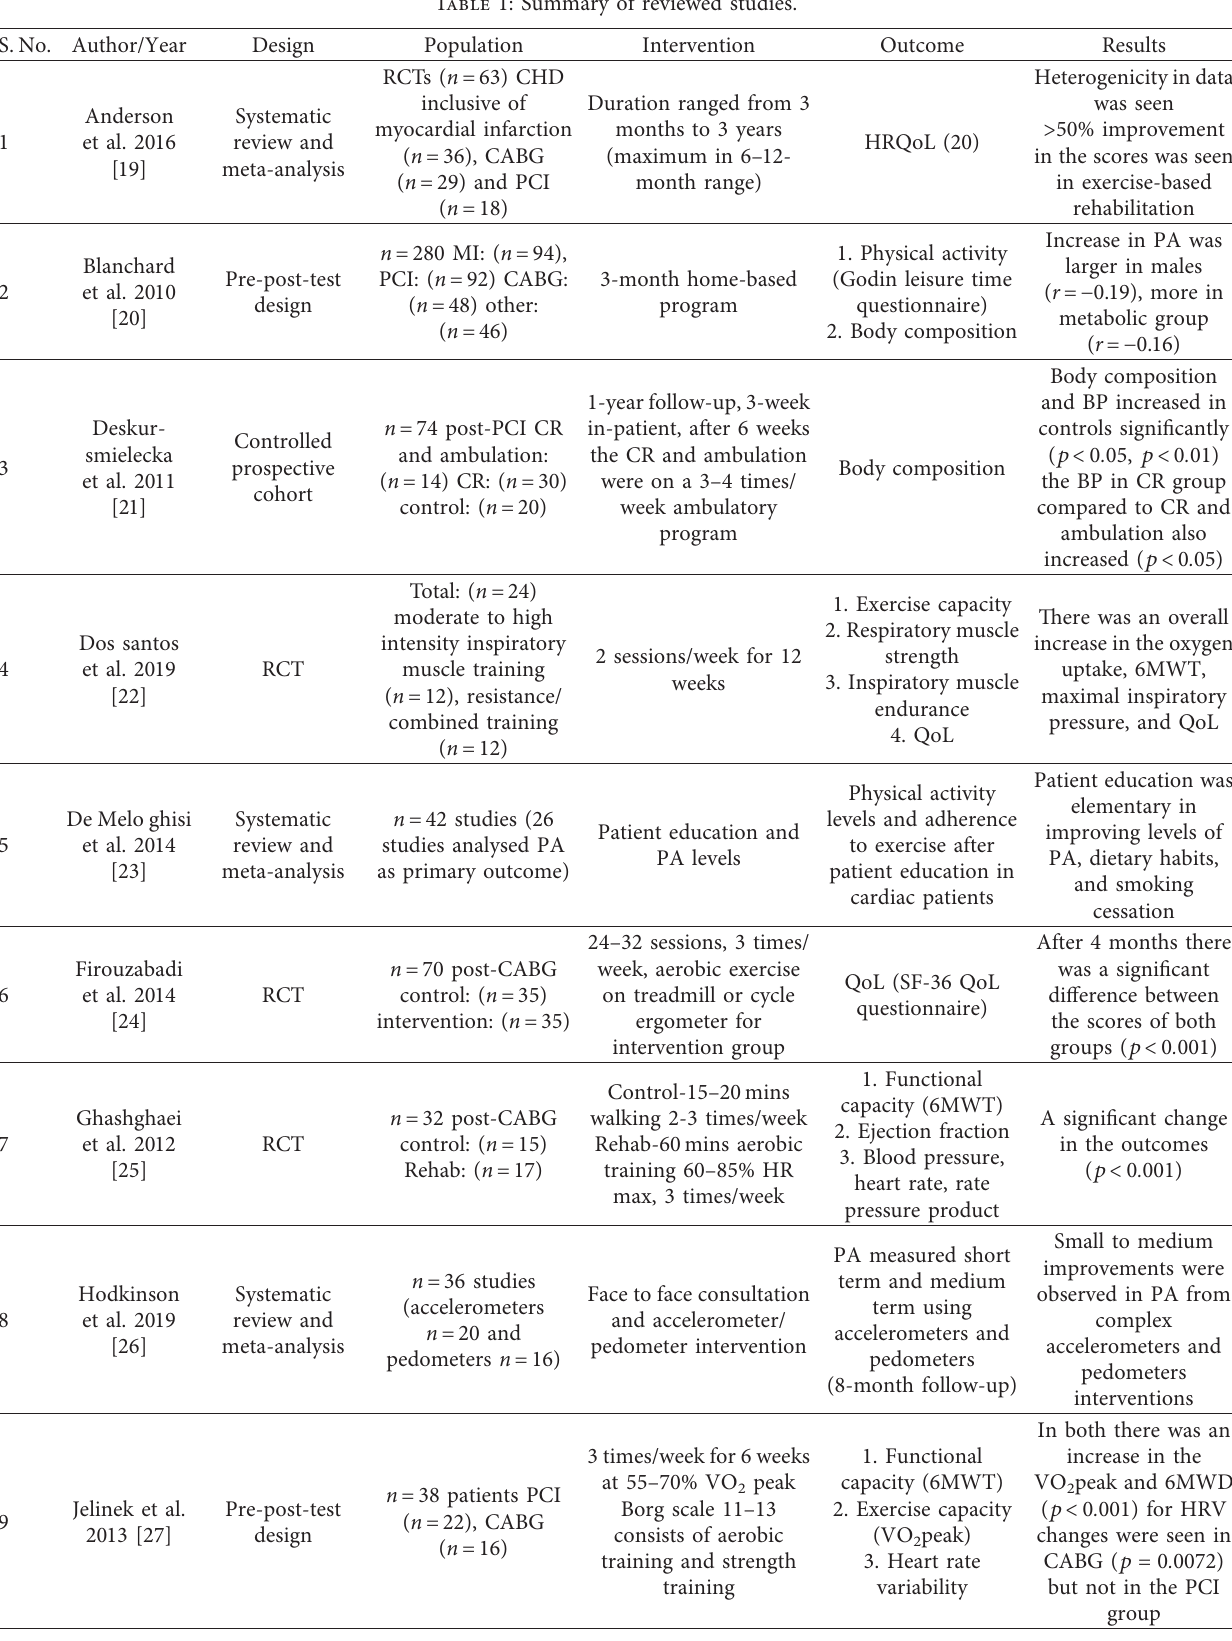
Table 1: Summary of reviewed